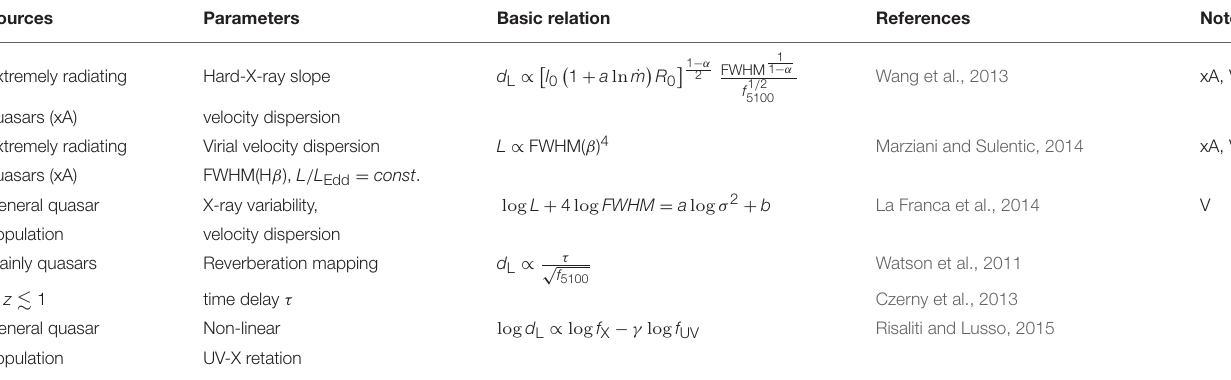
TABLE 1 | Table illustrating the foundations of several methods that have been proposed to exploit quasars as distance indicators.